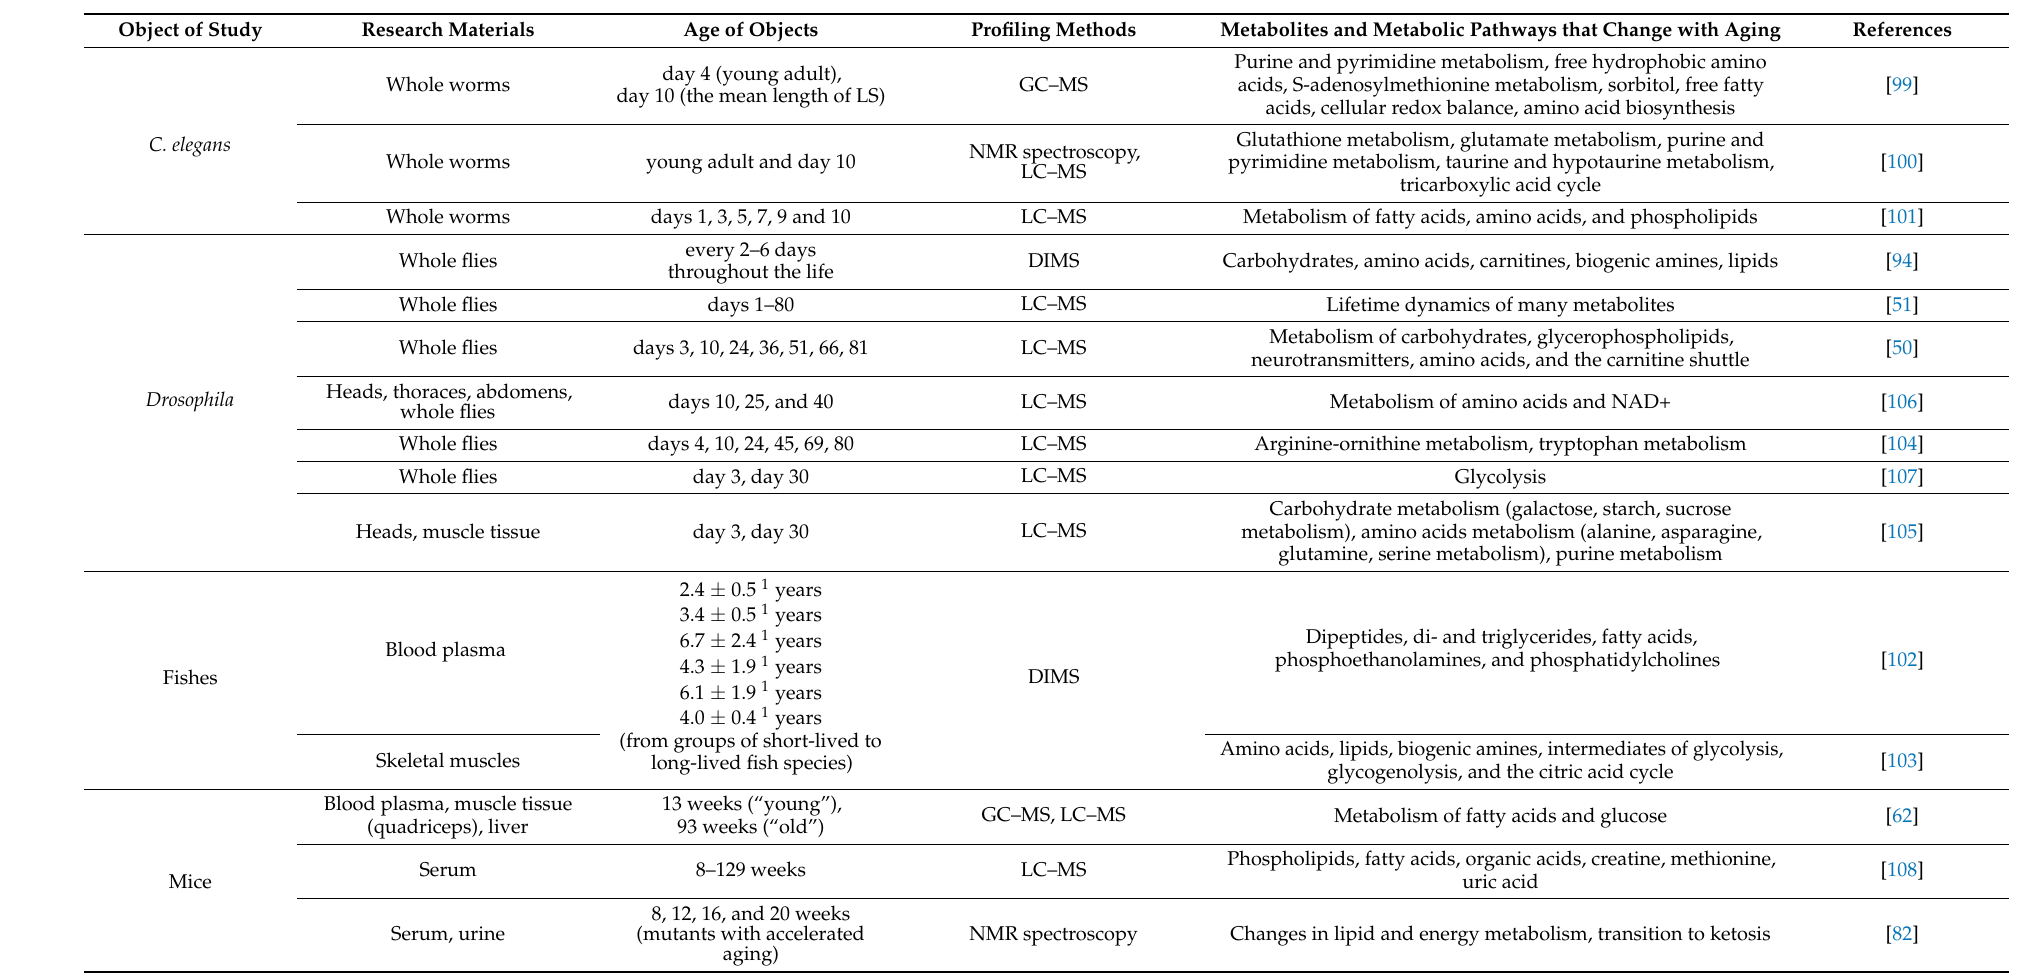
Table 2. Objects, methods, and main results of the studies presented in this